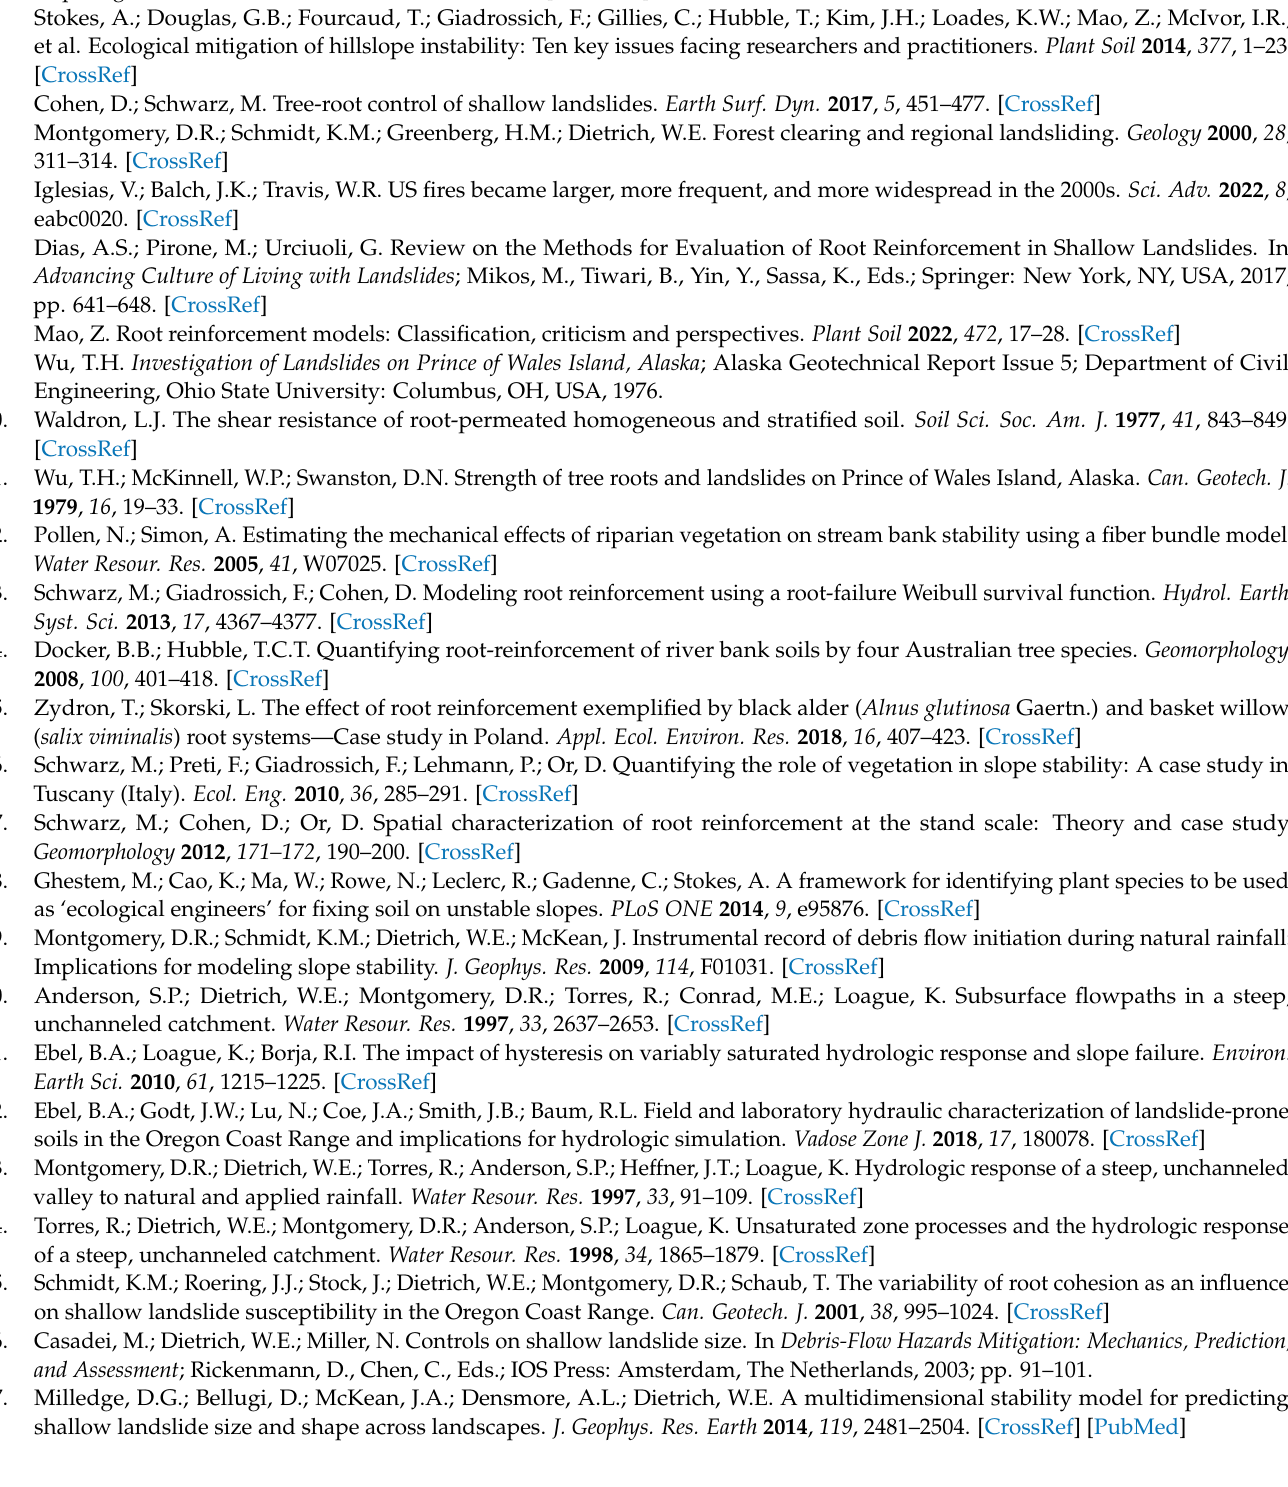
(Figure 7) are estimated separately for each species using maximum likelihood estimation (e.g., Lee